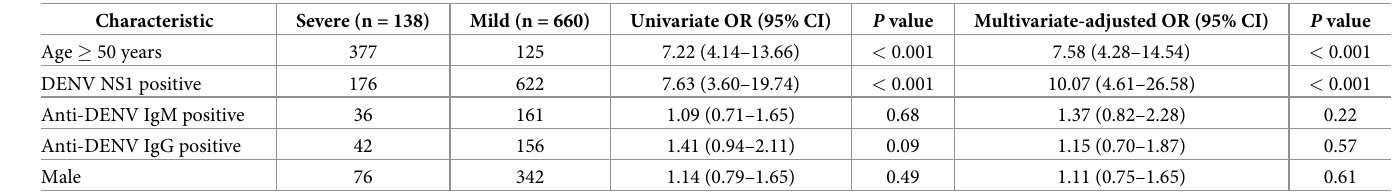
Table 2. Multivariate logistic regression model of clinical and laboratory diagnosis characteristics for dengue virus type 2 infection.